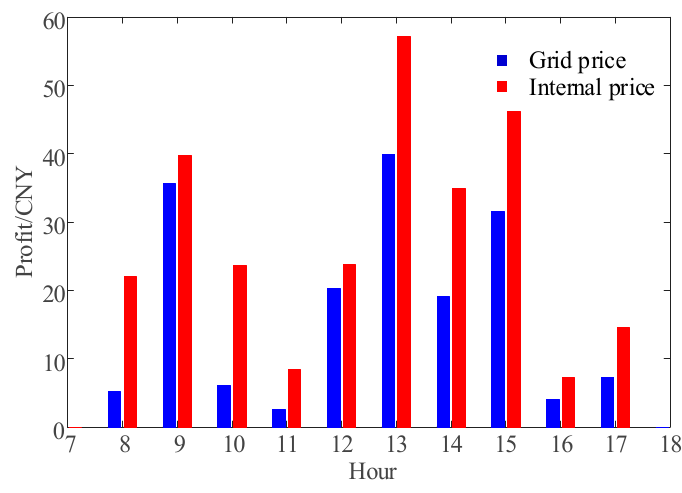
Figure 11. Comparison of the utility of the EMO.